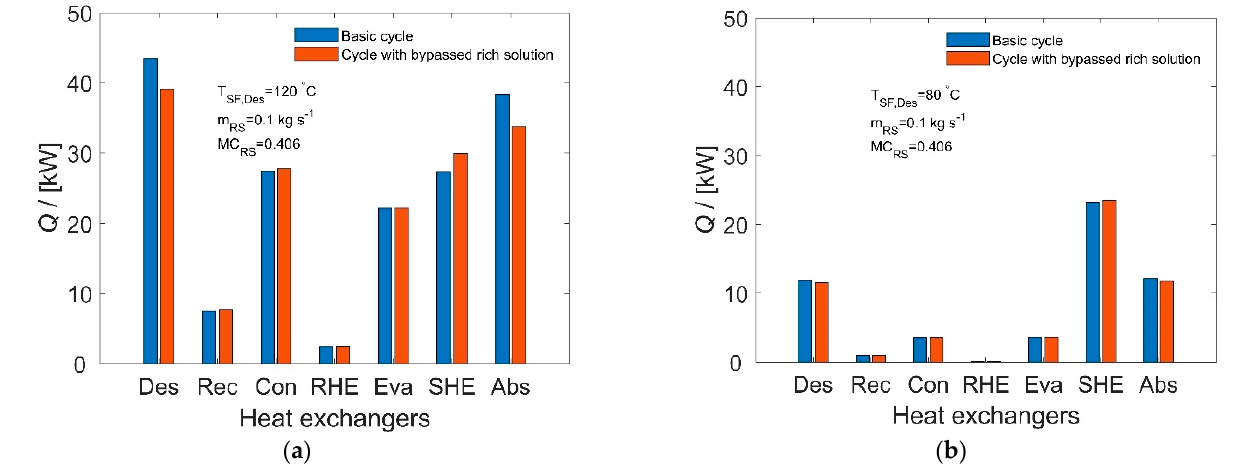
Figure 14. Heat exchanger loads of cycle with bypassed rich solution and basic cycle for different heat source temperature. ( a ) 120 °C, ( b ) 80 °C.